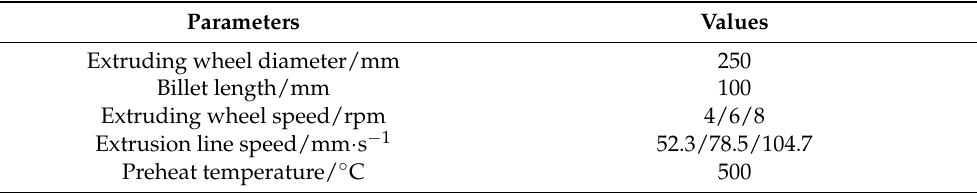
Figure 5. SEM image and EDS pattern of H62 brass. ( a ) SEM image of H62 brass ( b ) EDS pattern at position 2 of the bright area ( c ) EDS pattern at position 1 of the dark area. 3.2. Effects of Deformation Temperature The microstructure before and after upsetting at different deformation temperatures (deformation rate: 0.1 s −1 , deformation amount: 25%) is obtained in Figure 6. SEM micro- structures in the same region before and after upsetting deformation are described in Fig- ure 6a,a’ under room temperature (20 °C). The edge of α phase bulges and covers β’ phase after upsetting, which is attributed to the characteristics of the β’ phase. The ordered β’ phase transformed by the β phase has the characteristics of a high hardness and a low deformation ability at room temperature. The flow of α phase is higher than β’ phase, and β’ phase is covered by the α phase at this temperature. When the deformation temperature increases to 300 °C, although the α phase bulges, the severe covering phenomenon that α phase covers β’ phase is absent, which indicates that the flow of β’ phase increases rela- tively, as shown in Figure 6b,b’. As the deformation temperature increases to 400 °C, the phenomenon that the α phase covers β’ phase is not dominant. However, β’ phase could